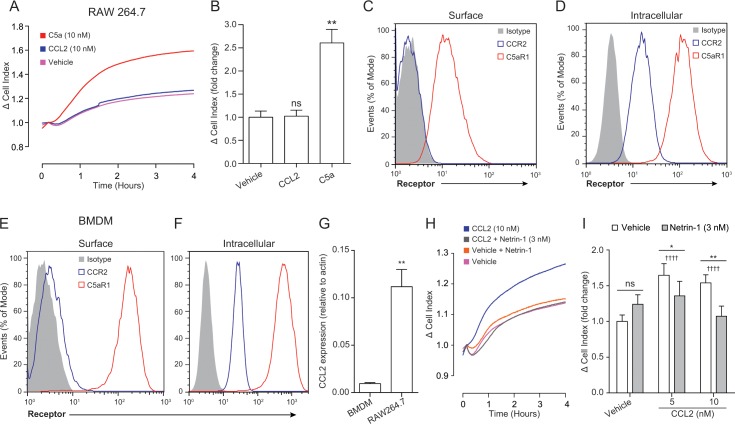
Netrin-1 inhibits primary macrophage chemotaxis towards CCL2.(A) RAW264.7 macrophages (1x105) were placed into the top chamber of a CIM-16 plate and allowed to migrate towards vehicle, C5a or CCL2 (both 10 nM) for 4 hours at 37°C, 5% CO2. (B) Quantification of RAW264.7 chemotaxis by Δ CI analysis. Data are mean + SEM, n = 3 biological replicates with 3–4 technical replicates per condition. RAW264.7 macrophages or BMDMs were stained for (C and E) surface or (D and F) intracellular levels of CCR2 and C5aR1 and analysed by flow cytometry. Histograms shown are representative of 3 biological replicates. (G) mRNA expression of CCL2 in BMDMs and RAW264.7 macrophages was determined using RT-PCR. Data are mean + SEM, n = 3 biological replicates. (H) BMDMs were treated with either vehicle or 3 nM netrin-1 for 45 min at 37°C, 5% CO2 prior to being placed into the upper chamber of a CIM-16 plate (1x105 cells/well). They were then allowed to migrate towards for 4 hours at 37°C, 5% CO2 towards vehicle or CCL2 at the indicated concentration. (I) Quantification of BMDM chemotaxis by Δ CI analysis. Data are mean + SEM, n = 3 biological replicates with 3–4 technical replicates per condition. For (B) statistical analysis was conducted by one-way ANOVA with Dunnett’s multiple comparisons correction. ns P > 0.05, ** P < 0.01 compared to vehicle. For (G) statistical analysis was conducted by unpaired two-tailed student’s t test. For (I) statistical analysis was conducted by two-way ANOVA with Sidak’s multiple comparisons correction. ns P > 0.05, * P < 0.05, ** P < 0.01, for indicated comparisons and †††† P < 0.001, compared to the respective vehicle control.